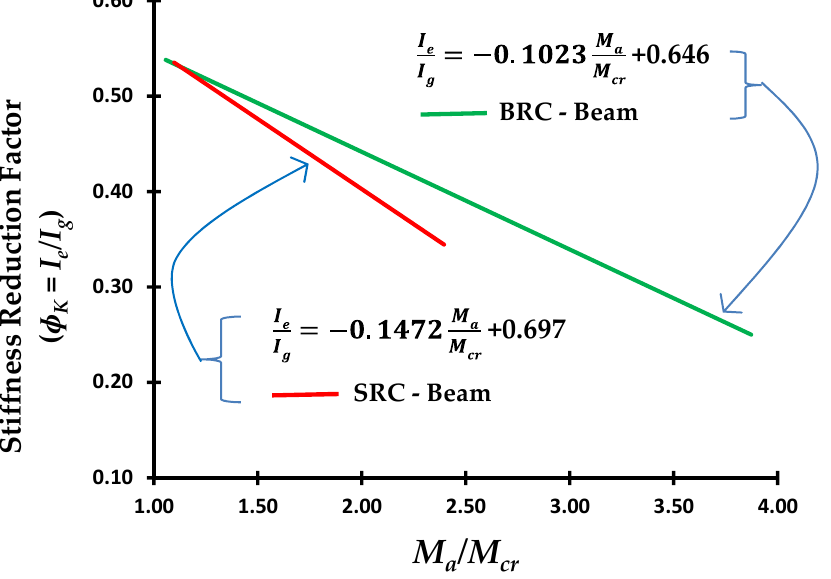
Figure 27. Comparison of the relationship of the sti ff ness reduction factor ( φ K ) and the M a / M cr of the BRC beam and SRC beam. Table 9. The alternative value of I for elastic analysis from various sources.